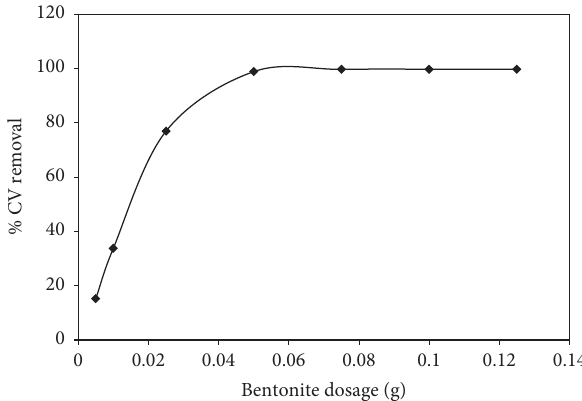
Figure 7: Effect of bentonite dosage on the removal of CV.